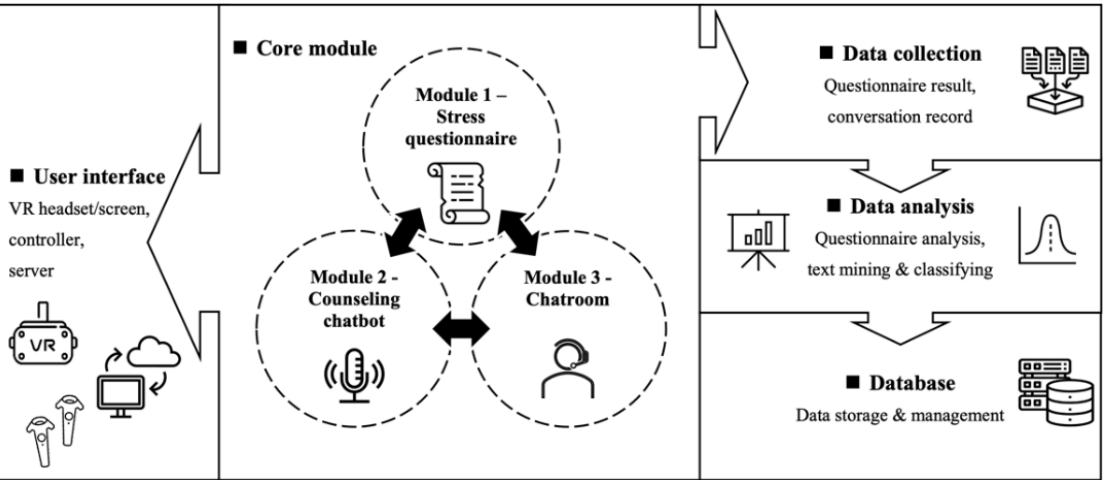
Figure 7. The system framework integrating the online questionnaire, counseling chatbot, and group counseling chatroom.